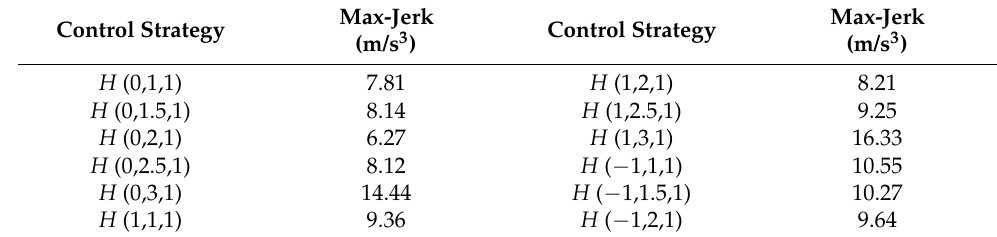
Table 2. Jerk corresponding to different control strategies.